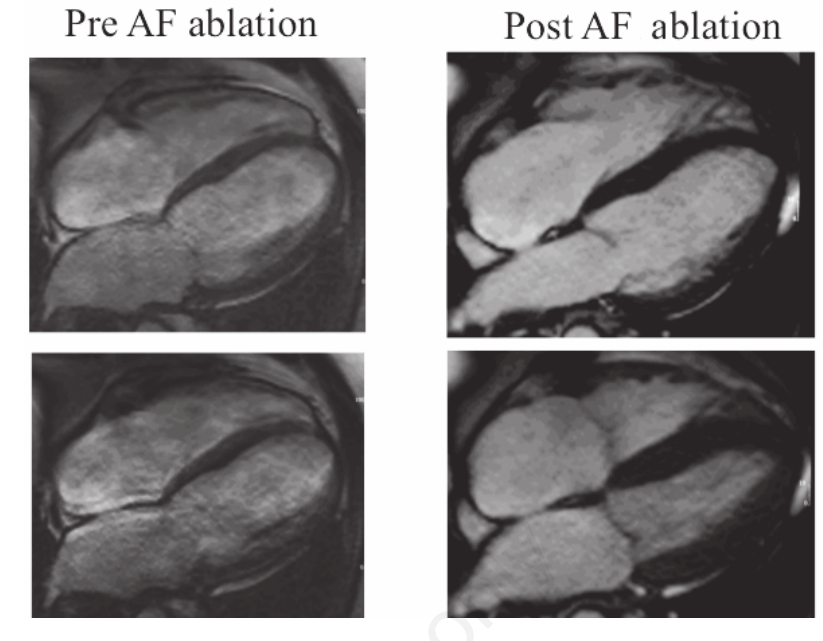
Figure 1 and online Videos 1-2. Cardiovascular magnetic resonance steady-state free pre- cession cine still frames (diastole top panels, systole bottom panels), showing poor